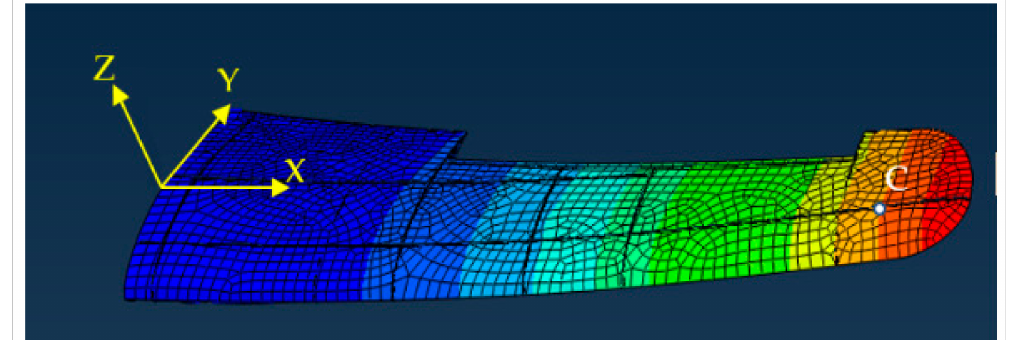
Figure 11. The contour plot of the wing deformation.